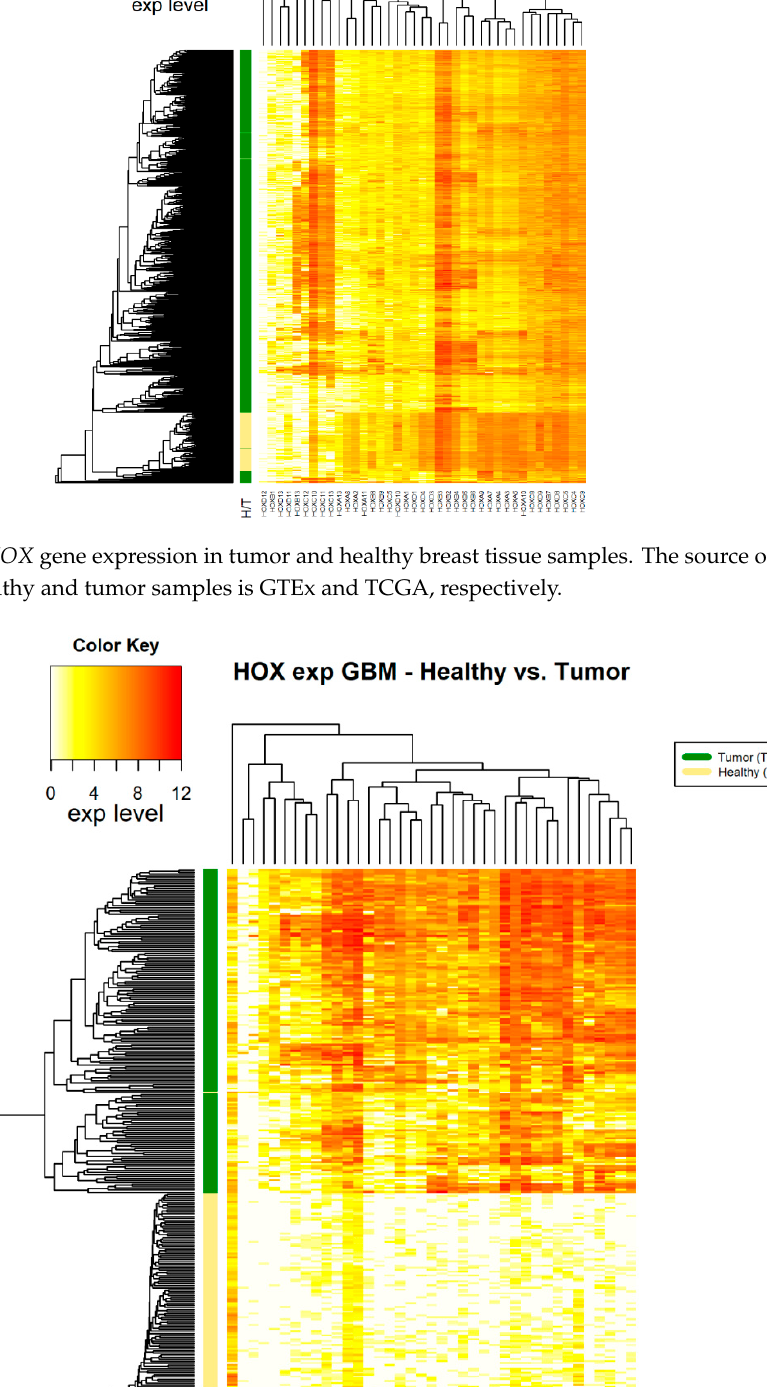
Figure 3. HOX gene expression in samples of healthy brain tissue and glioblastoma multiforme tumor tissue. The source of expression data of healthy and tumor samples is GTEX and TCGA, respectively.